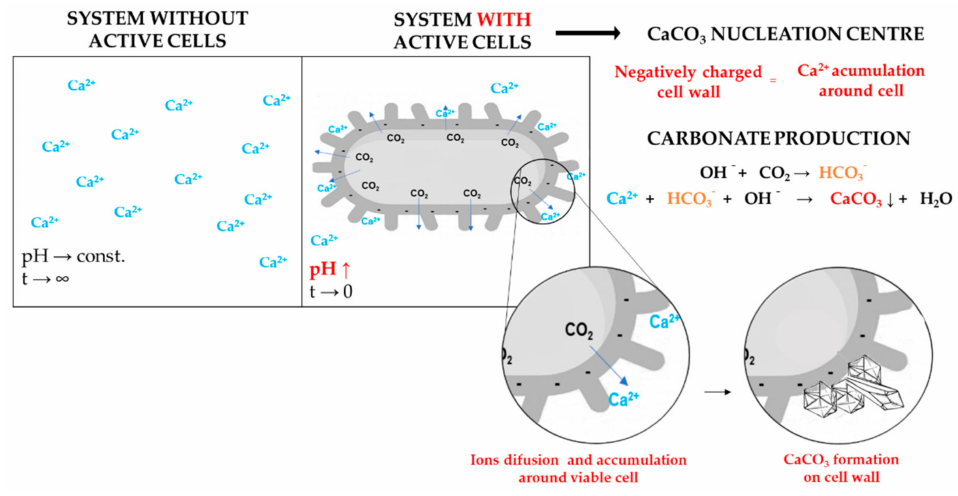
Figure 1. Bacterial cell as an active nucleation